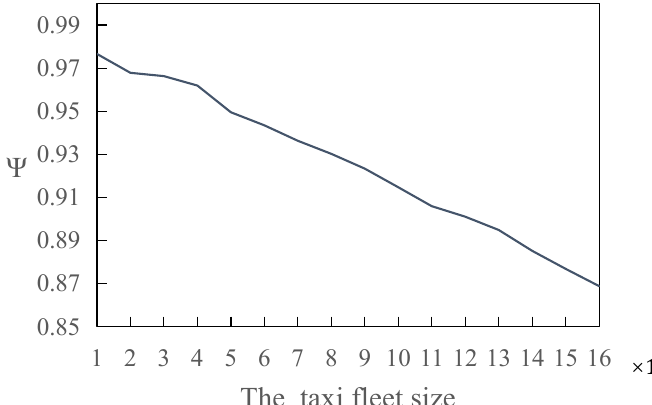
0.850.870.890.910.930.950.970.99 × 10 (cid:2871) The taxi fleet size Figure 4. Ratio of maximum social welfare in case 1 to that in case 2 against various taxi fleet sizes.